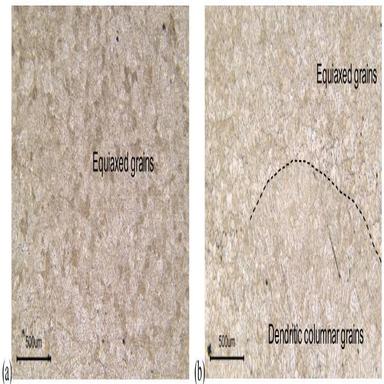
Optical microscopy images at two locations: (a) XY plane, and (b) YZ plane.